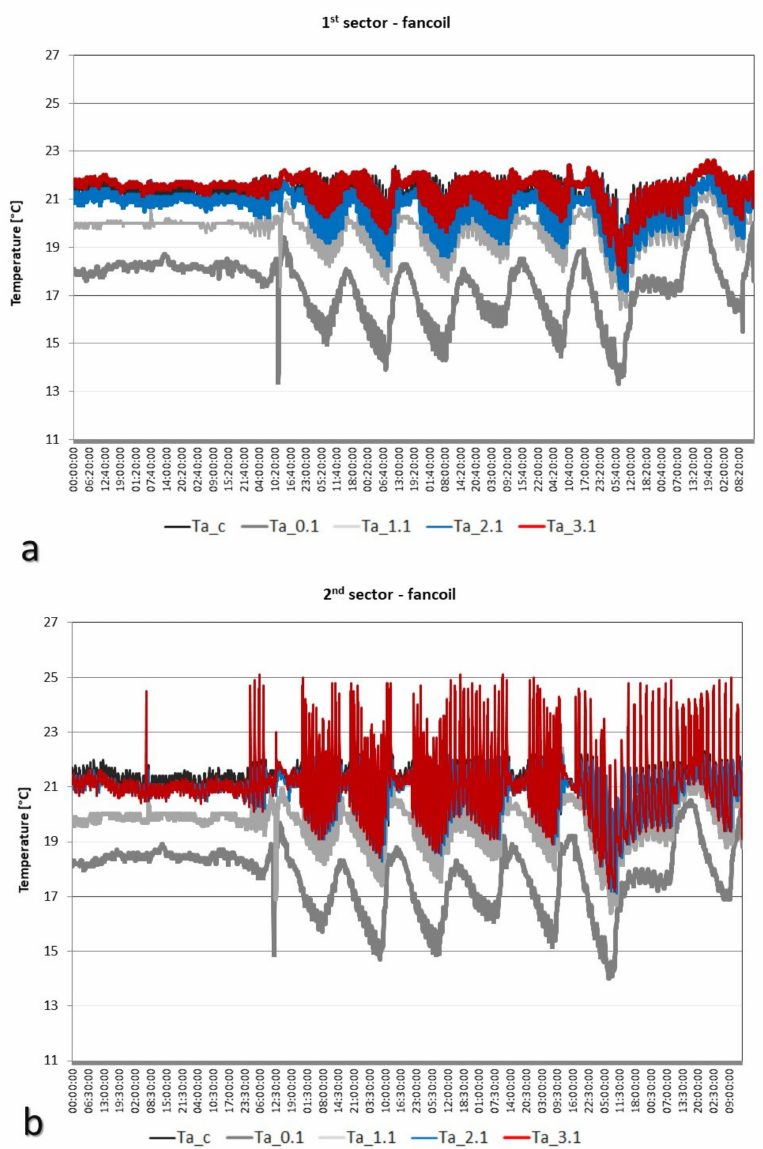
Figure 9. Air temperature at different heights with fan coil units: ( a ) 1st sector, ( b ) 2nd